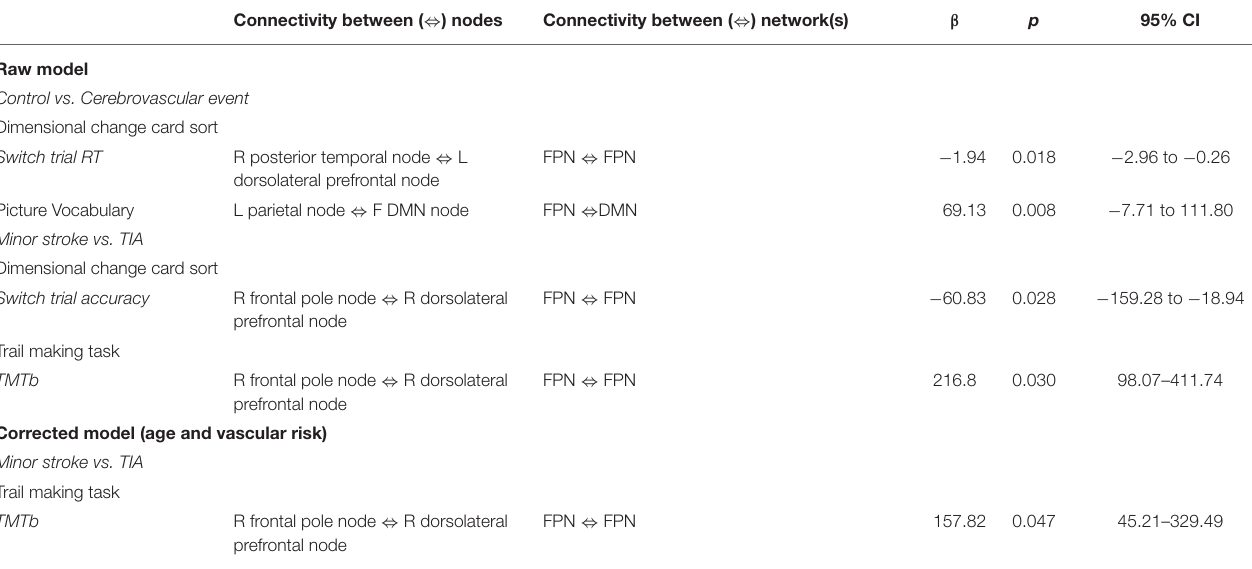
TABLE 5 | Interaction between functional connectivity and groups on cognitive outcomes. Connectivity between ( ⇔ ) nodes Connectivity between ( ⇔ )